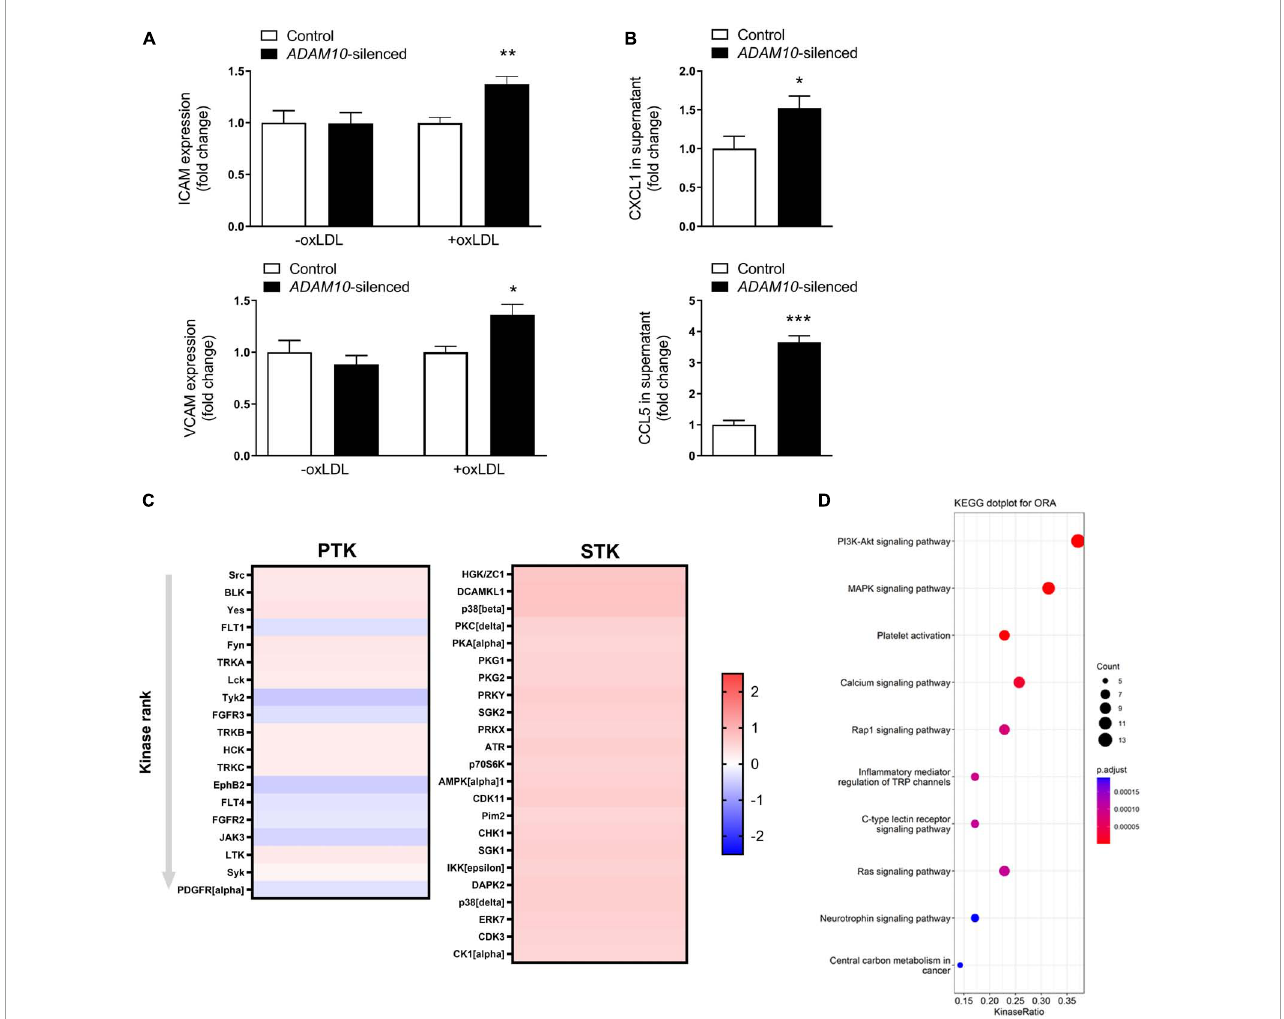
FIGURE5 ADAM10 silencing results in a pro-inflammatory, pro-atherogenic phenotype in HCAECs. (A) Surface expression of ICAM and VCAM, measured by flow cytometry in control and Adam10 silenced HCAECs stimulated with or without 25 µ g/ml oxLDL for 24 h ( n = 3–6). Fold change has been determined for each condition by comparing to the respective control condition. (B) Quantification of soluble CCL5 and CXCL1 in supernatant of control and ADAM10 silenced HCAECs stimulated with 25 µ g/ml oxLDL for 24 h, measured by ELISA ( n = 8–11). (C) Kinomic analysis of control and ADAM10 silenced HCAECs stimulated with 25 µ g/ml oxLDL for 30 min. Visualized is the heatmap of kinases that are up-regulated upon ADAM10 silencing after oxLDL stimulation. Red color reflects increased phosphorylation, while blue color reflects decreased phosphorylation in ADAM10 silenced HCAECs (fold change compared to scrambled control cells, n = 4). (D) Dot plot for over-representation analysis (ORA) of KEGG with significant differences from control using the PTK and STK dataset. Visualized are the top 10 of upregulated pathways in ADAM10 silenced HCAECs, stimulated with 25 µ g/ml oxLDL for 30 min. * p ≤ 0.05; ** p ≤ 0.01; *** p ≤